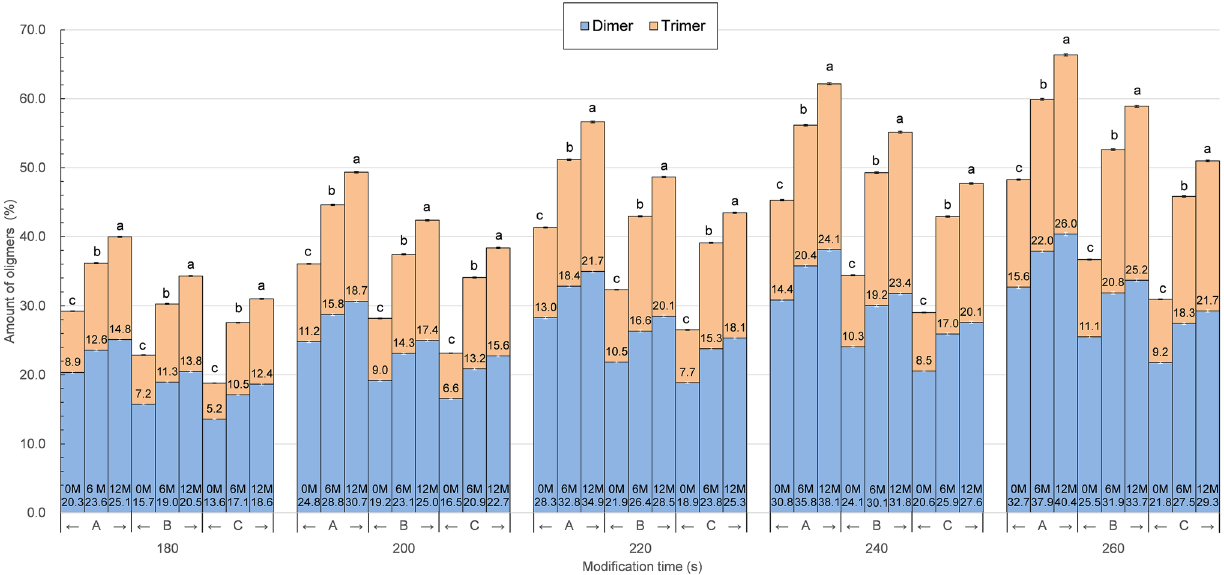
Figure 2. Characterization of the oligomeric properties of an LLC with the modified process, cold storage time, and pH (storage time: 0, 6, and 12 months, time of modification: 180, 200, 220, 240, and 260 s, pH: A-2.0, B-3.0, and C-4.0). ( a – c ) Different letters on the bars denote a significant difference in the means at p ≤ 0.05. The top of the bar—trimer. The bottom of the